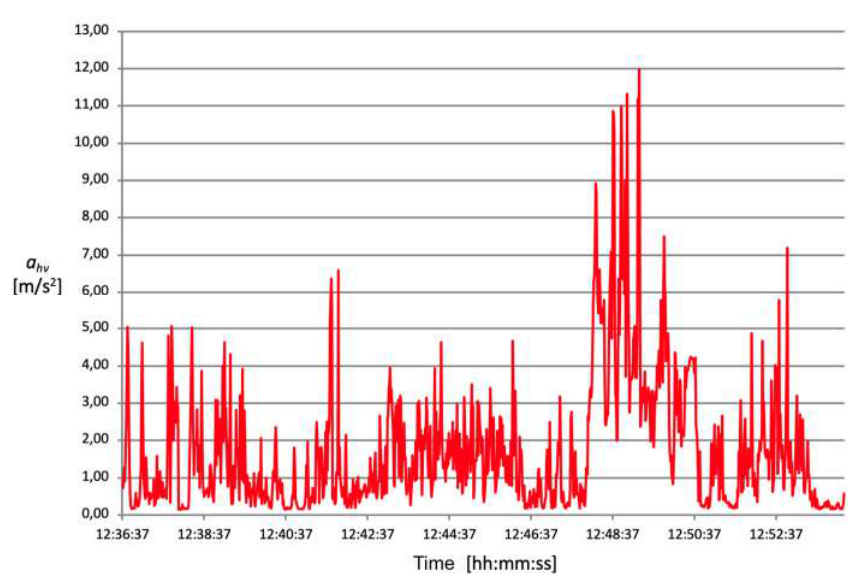
Figure 7. Acceleration root mean square distribution over time, detected on 07.12.2016 registration n. 2.